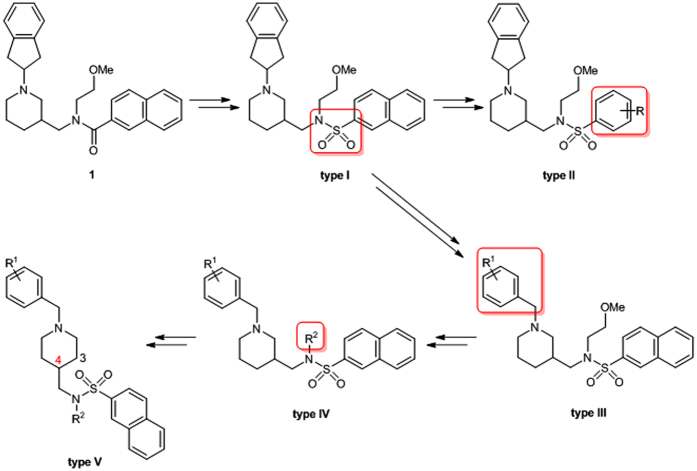
Design of sulfonamide analogs of hit compound 1.The modifications introduced during each design step are indicated in red.